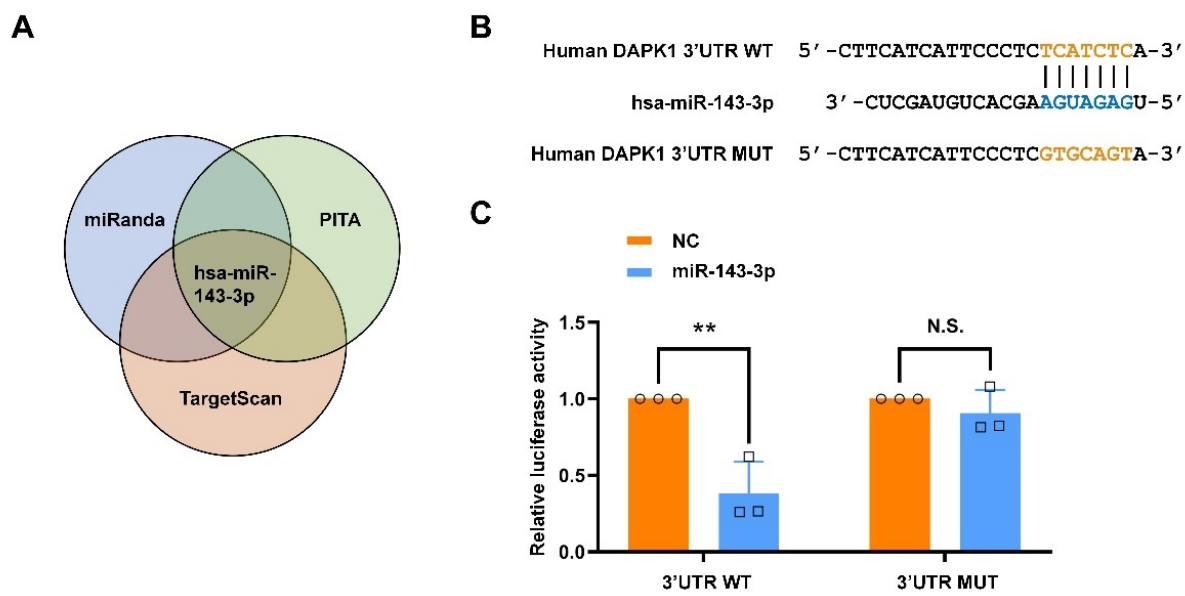
Figure 1. Hsa-miR-143-3p directly targets human DAPK1. ( A ) Hsa-miR-143-3p was predicted as one of the miRNA candidates targeting human DAPK1 using the miRanda, PITA, and TargetScan data- bases. ( B ) The sequence of the hsa-miR-143-3p WT binding site within the 3 ′ UTR of human DAPK1 mRNA predicted by TargetScan and the sequence of the MUT binding site was cloned into the pmirGLO dual-luciferase vector. ( C ) The relative luciferase activity in HEK 293 cells cotransfected with hsa-miR-143-3p mimics (miR-143-3p) or miRNA negative control (NC) group and the vector including WT or MUT binding sequence was detected by dual-luciferase reporter assays. The data (circles and squares) are presented as the mean ± SD of three independent experiments (** p < 0.01, N.S., not significant).